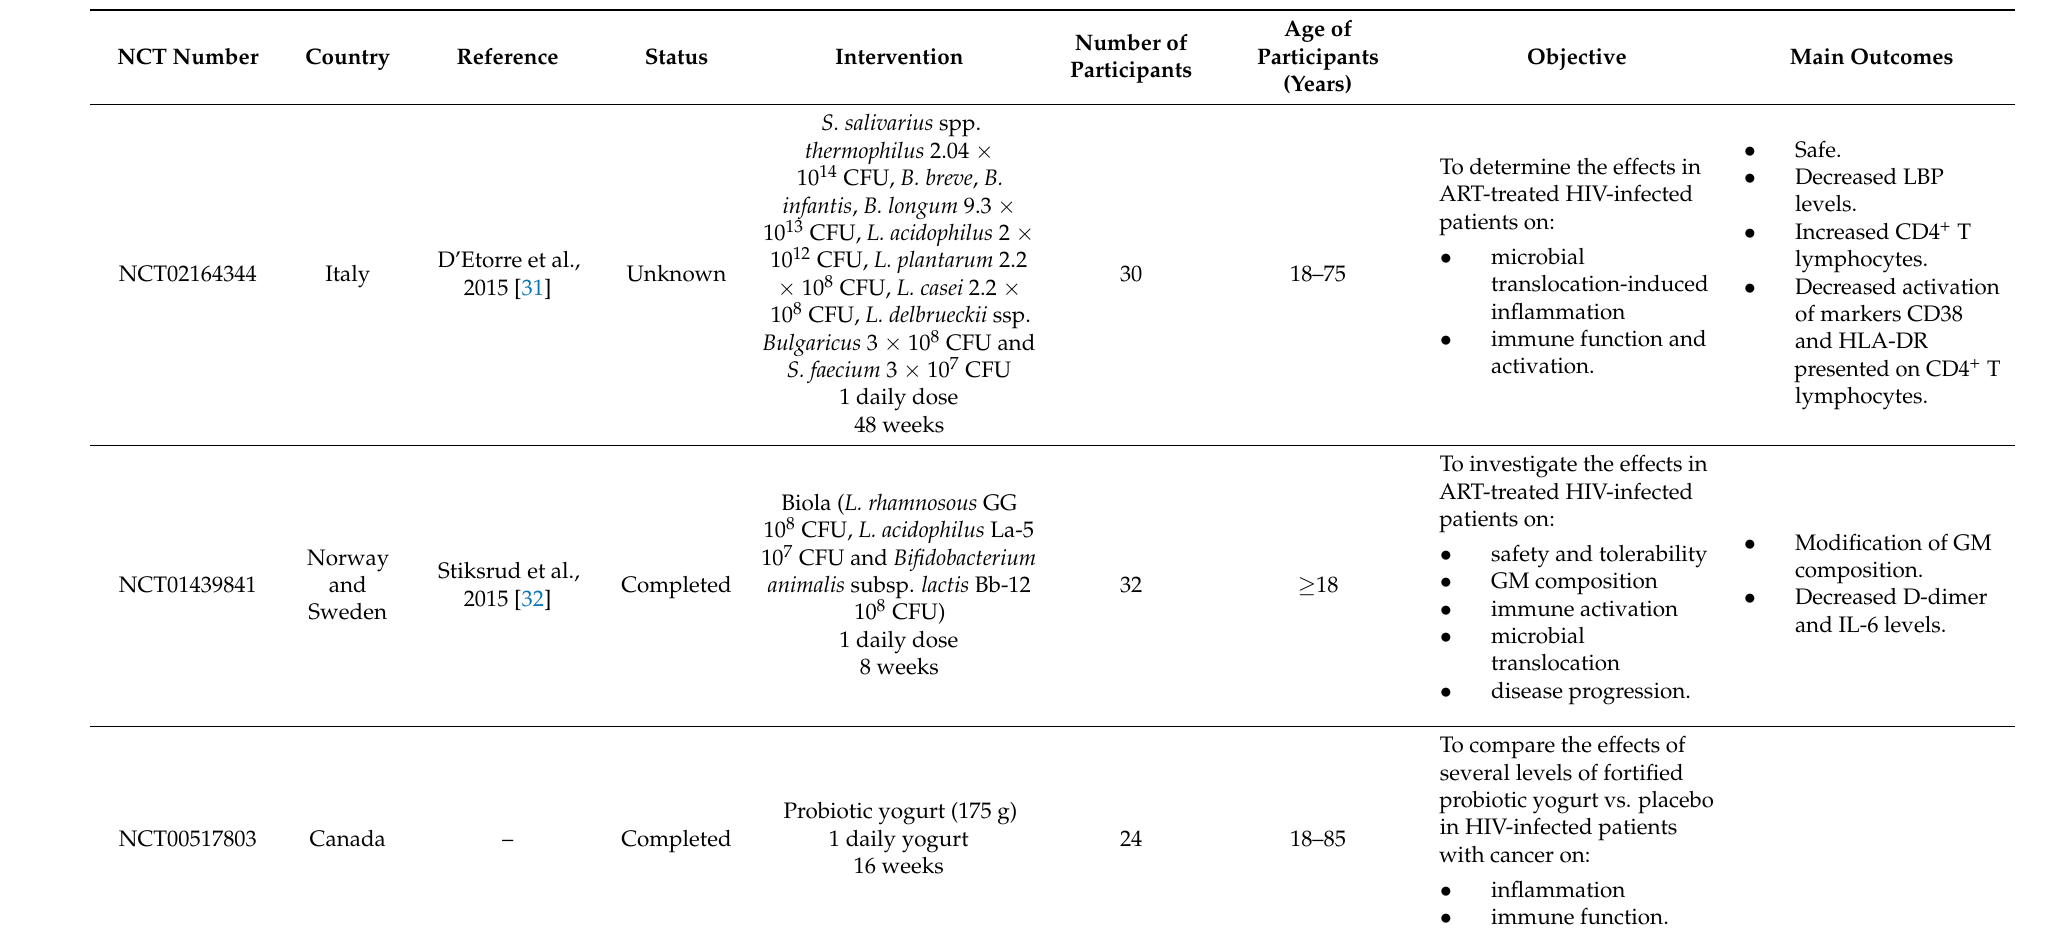
Table 2. Clinical trials concerning probiotics registered in